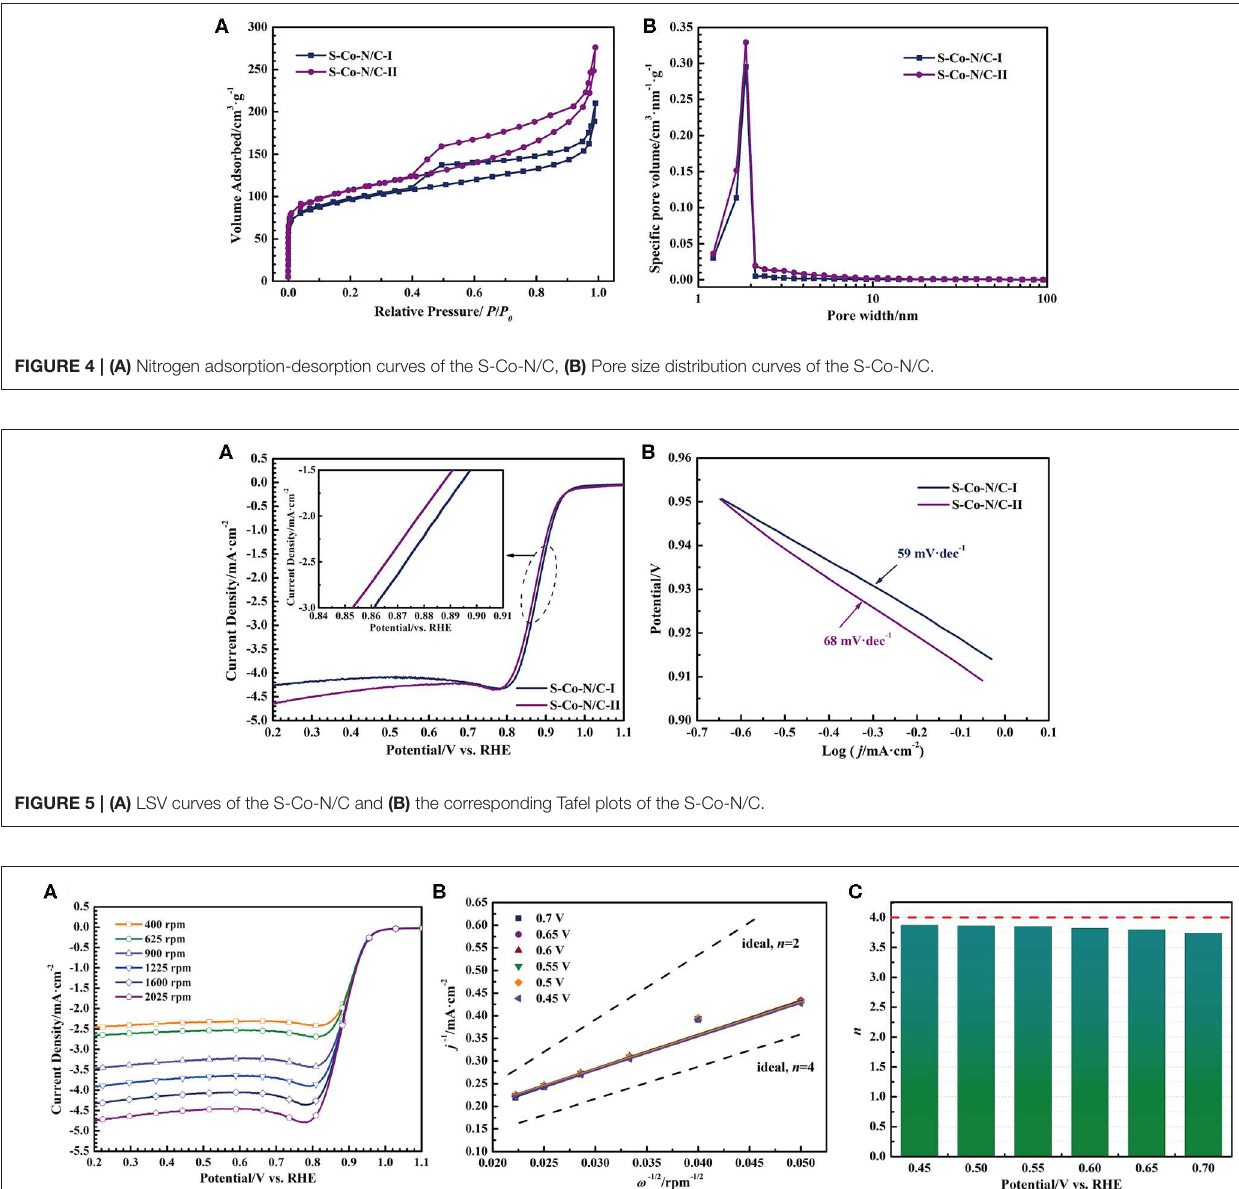
(68 mV · dec − 1 ), which proves a lower overpotential of the oxygen reduction reaction catalyzed by the